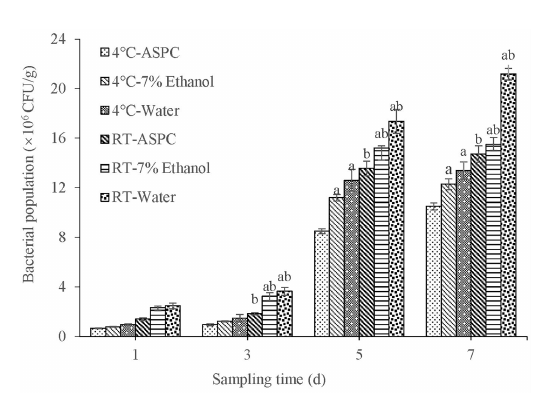
FIGURE 4 Colony numbers of raw shrimp treated with ASPC, 7% ethanol, and sterile water after 1, 3, 5, and 7 days at 4 ° C and room temperature. Compared with the ASPC group, the letter “a” represents p < 0.05. Compared with the 4 ° C group, the letter “b” represents p <